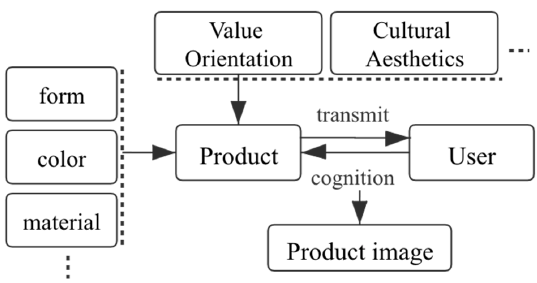
Figure 2. The formation process of product image.